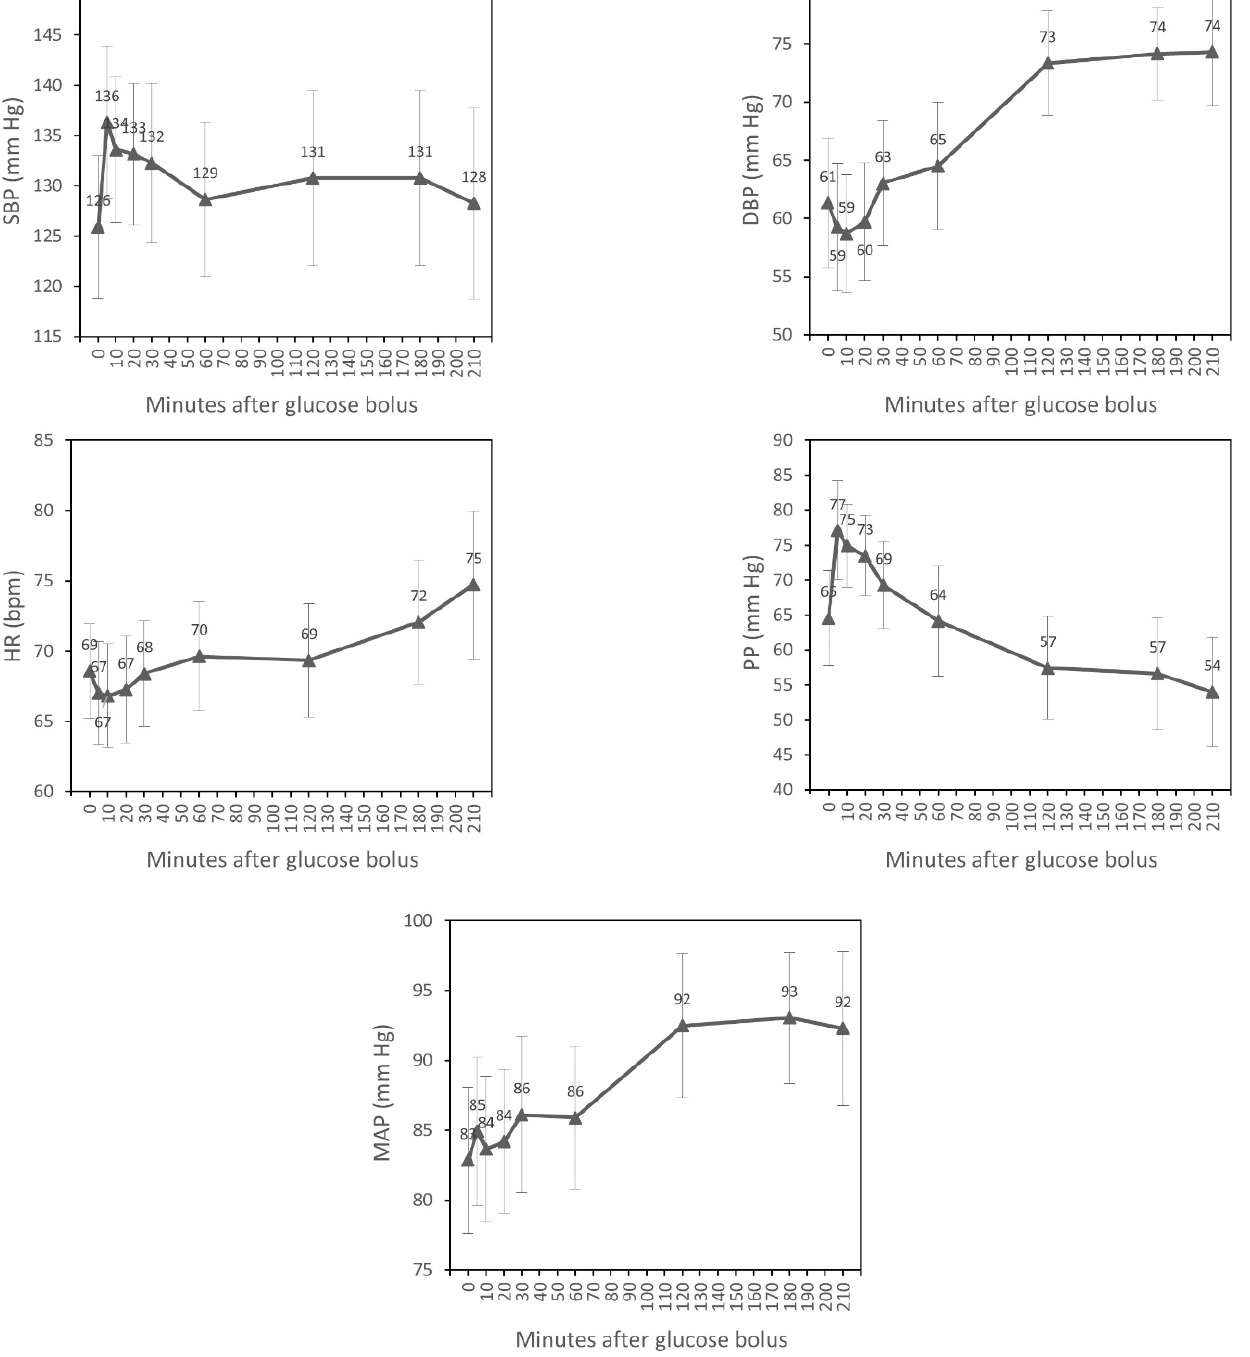
Figure 1. Time course of hemodynamic parameters during hemodialysis (estimated marginal means, 95% CI ).